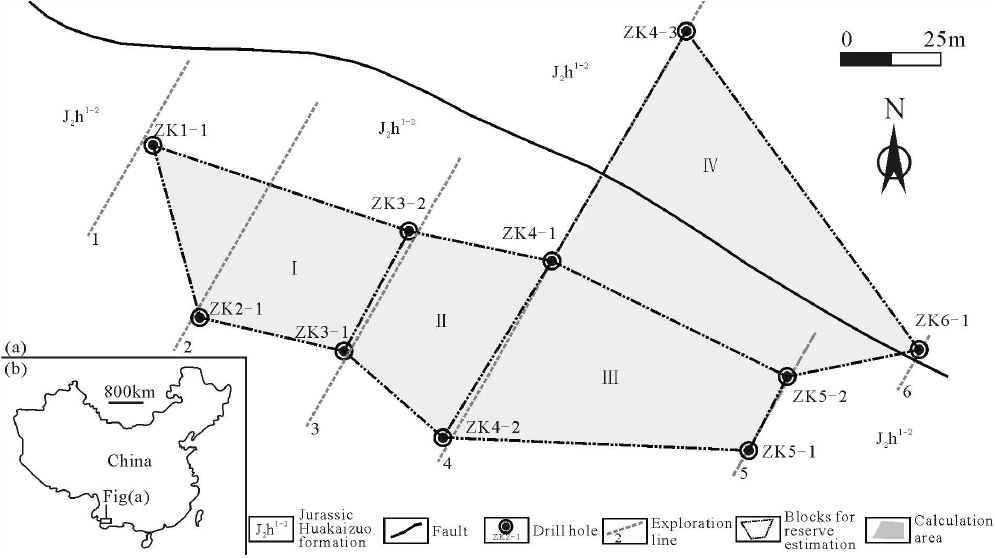
Fig. 5. Geologic setting and locations of the 10 selected drill holes in the Reshuitang gold deposit, Sanjiang ore belt, China (The map is based on the exploration material provided by the Yunnan Mineral Resources Limited Liability